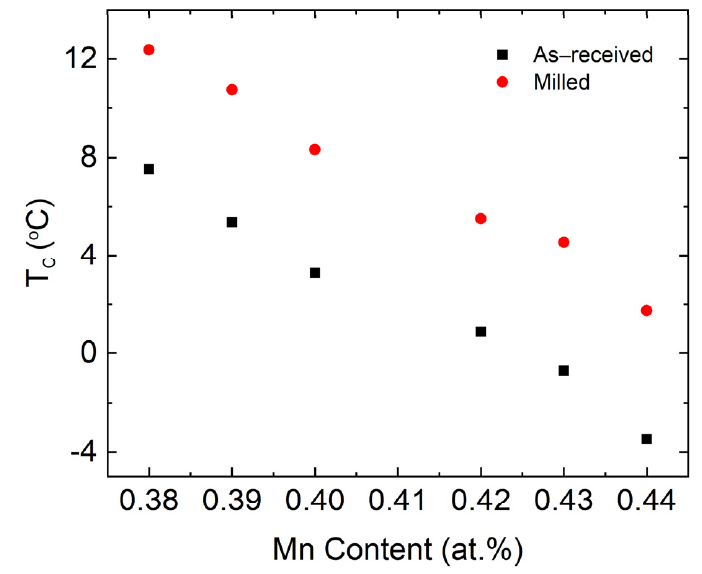
Figure 7. The T c for both the as-received and milled powders as a function of the Mn content, as determined from the DSC experiments.